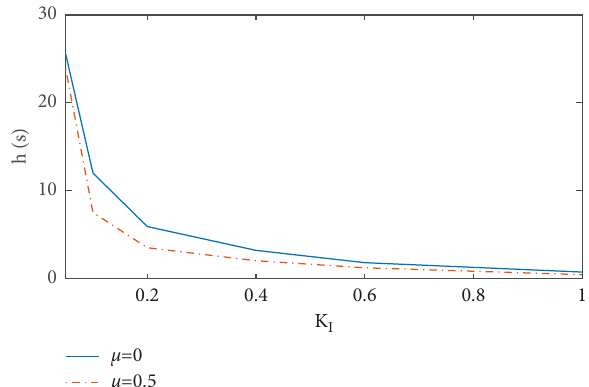
Table 4: Delay margin h by Theorem 1 for single-area LFC with ϱ � 0 , τ � 0.